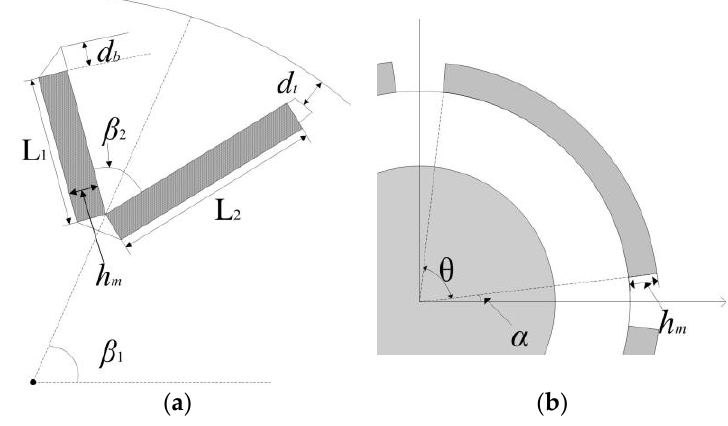
Figure 6. Design parameters of the PMs. ( a ) Embedded type; ( b ) Surface-mounted type. Table 3. Design variables of the rotor.